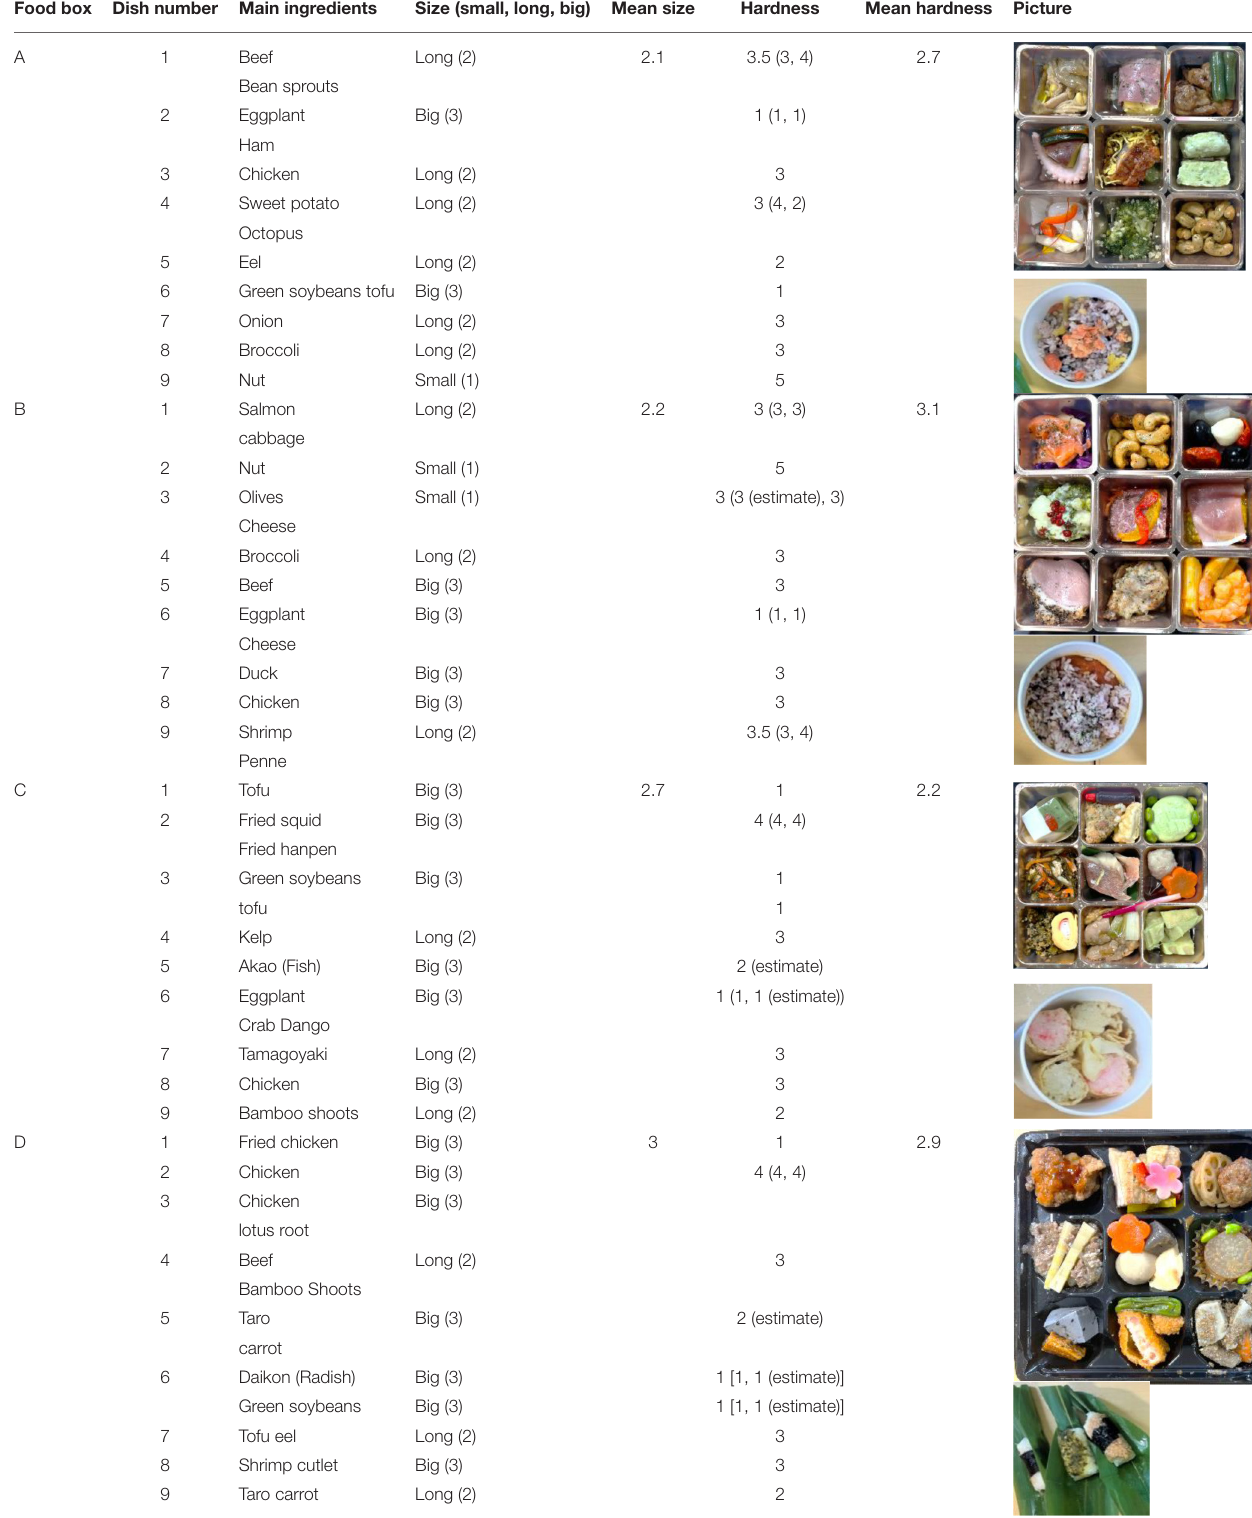
TABLE 1 | Main ingredients, size, and hardness of the dishes in lunch boxes A–D. Food box Dish number Main